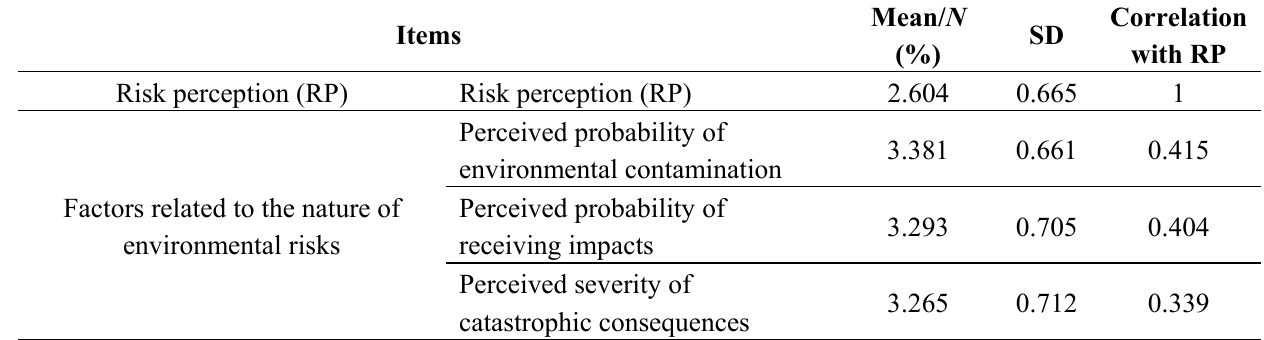
Table 6. Average risk-perception score and descriptive statistics of potential predictors.